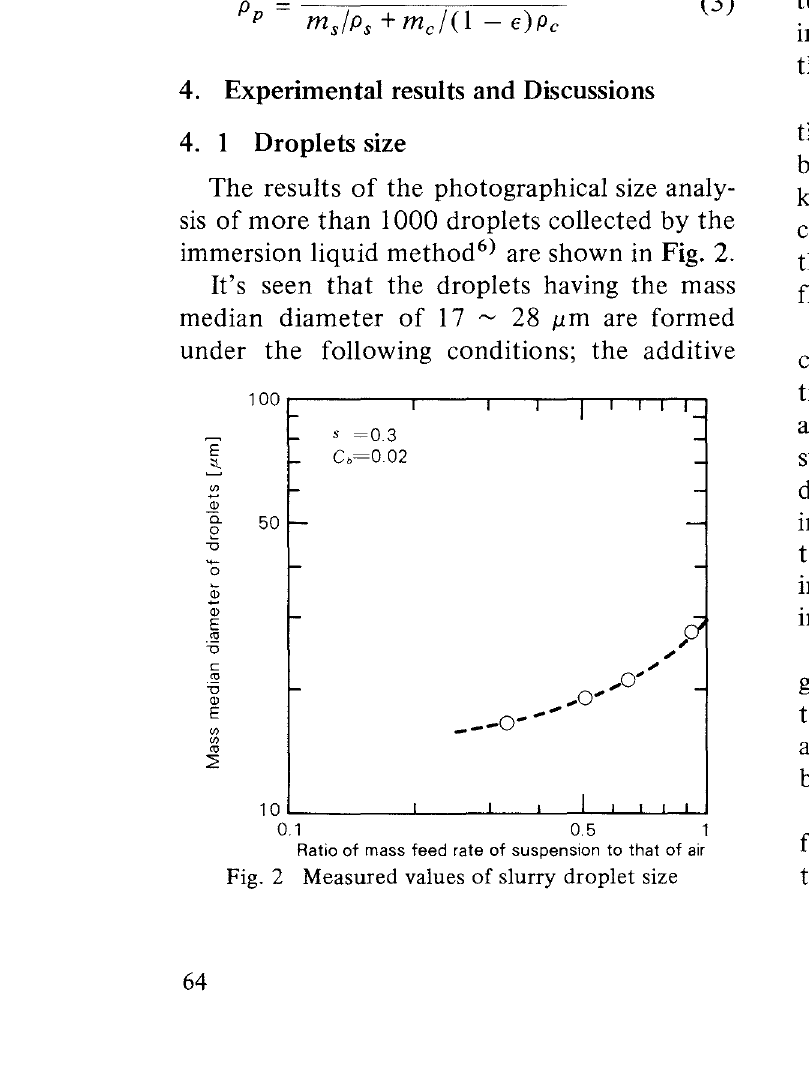
Fig. 2 Measured values of slurry droplet